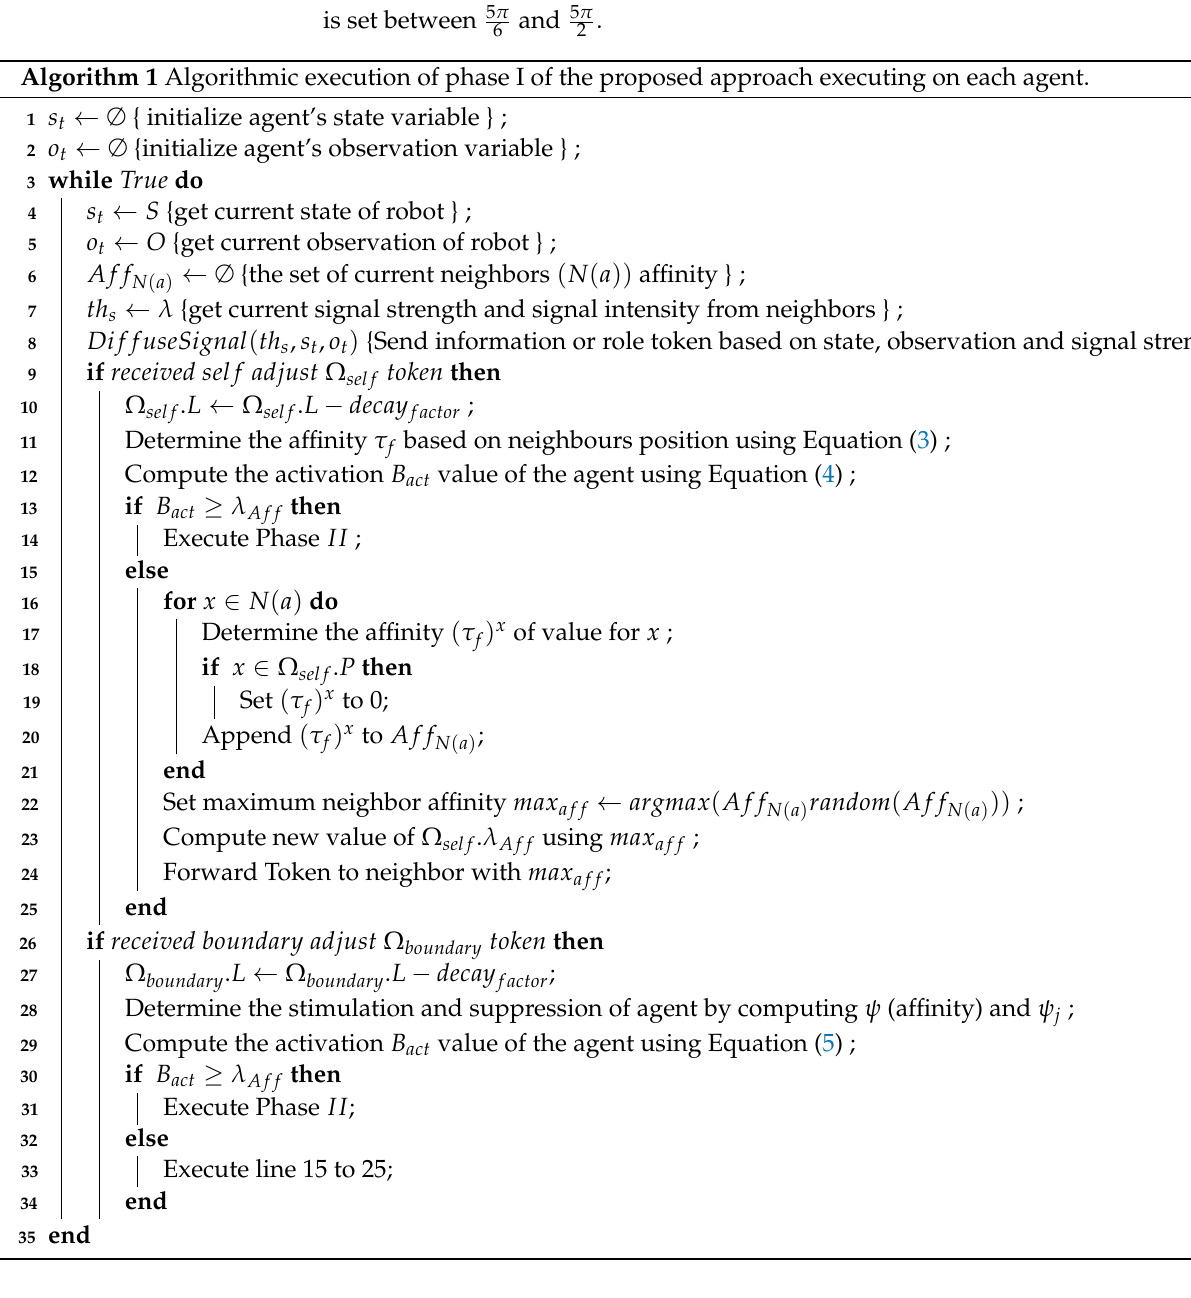
Algorithm 1 Algorithmic execution of phase I of the proposed approach executing on each